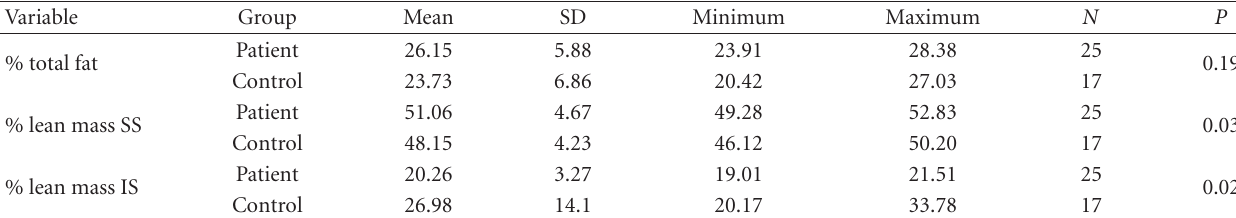
Table 3: Body composition (percentage of total fat mass and lean mass): comparison between SCI group and controls.